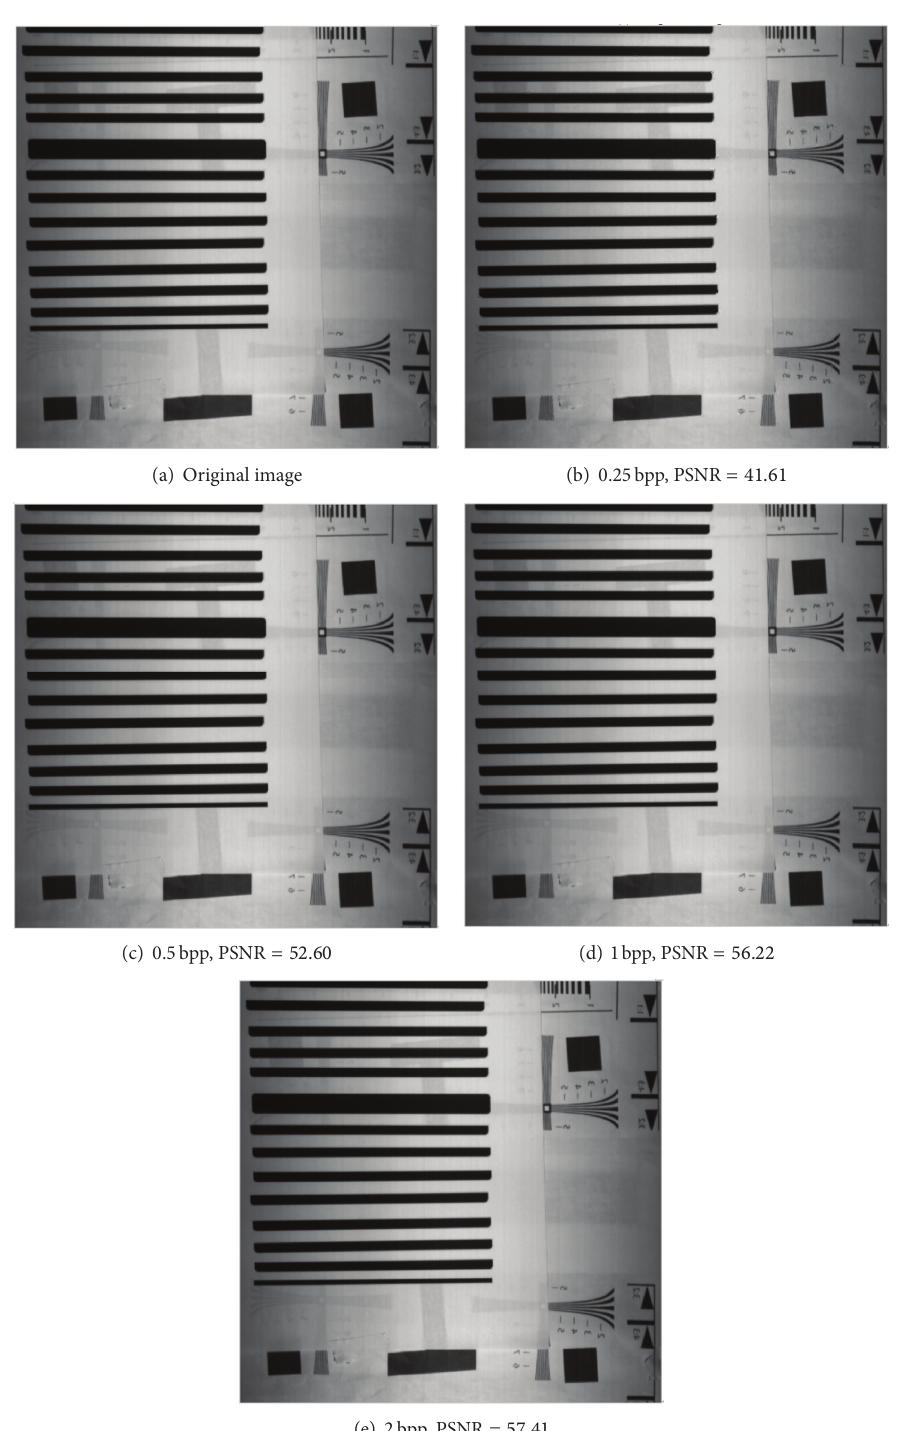
Figure 19: Reconstructed image at different bit